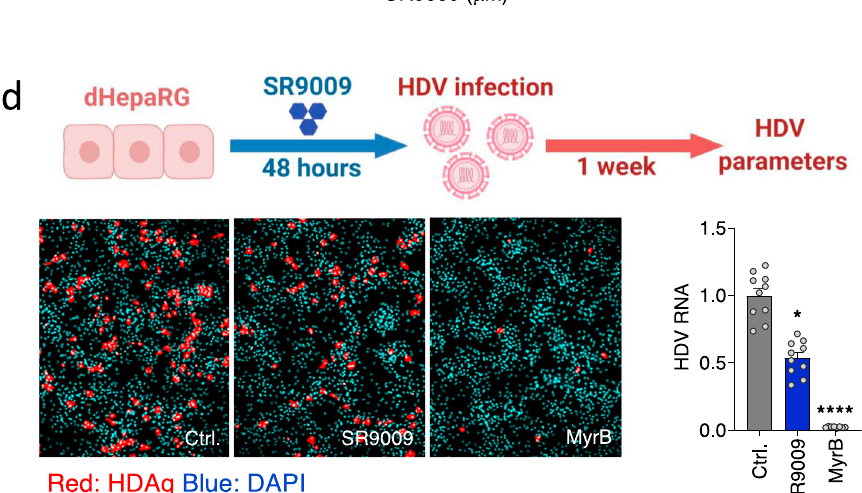
NATURE COMMUNICATIONS| (2021) 12:1658